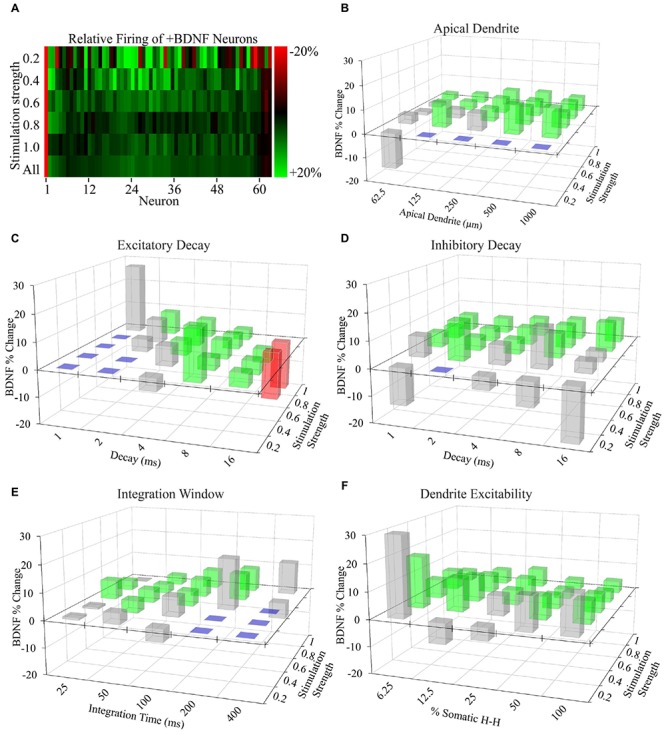
Increased AP generation by +BDNF model neurons is robust with respect to non-empirically based parameter values. (A) Heat map showing the average difference between the ranked -BDNF and +BDNF model neurons as displayed in Figure 4E. The differences are represented as the % difference between the +BDNF model neuron and its corresponding -BDNF model neuron counterpart from the rank order of Figure 4E. (B–F) Testing the effects of “unconstrained parameter” value ranges from the literature on the behavior of model neurons. Three-D bar graphs showing the percentage change between the average rate of AP generation for the entire group of +BDNF and -BDNF model neurons for each non-empirically based parameter value tested. Green bars indicate parameter values where the average +BDNF models produced significantly more APs than the average -BDNF models (p < 0.05). Red bars indicate parameter values where the +BDNF models produced significantly fewer APs than the average -BDNF models (p < 0.05). Gray bars indicate parameter values for which there was no significant difference in AP generation between the average ±BDNF models (p > 0.05). Purple squares indicate that less than half of the neurons produced a single AP at this parameter value, and thus comparisons were not made. Statistical significance was assessed with unpaired t-tests comparing the average AP rate for the -BDNF models and the +BDNF models. N = 63 model neurons per comparison.